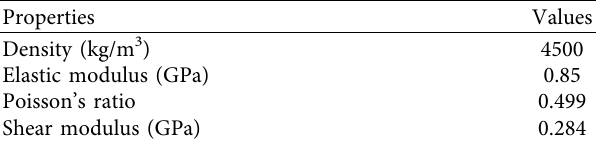
Table 2: Properties for carbon composite.